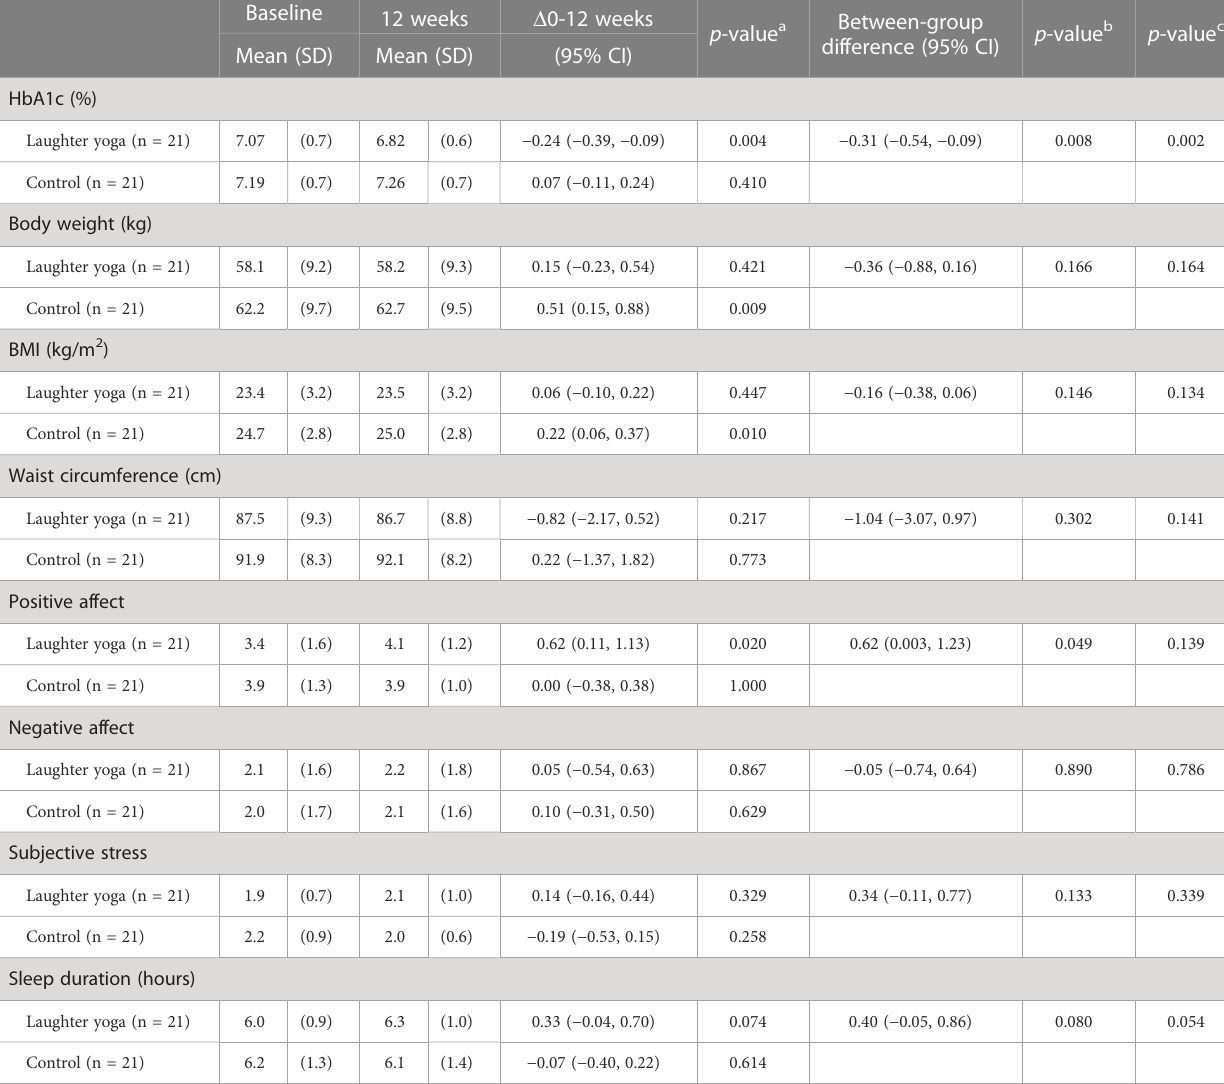
TABLE 2 Physiological and psychological changes during the intervention in the laughter yoga and control